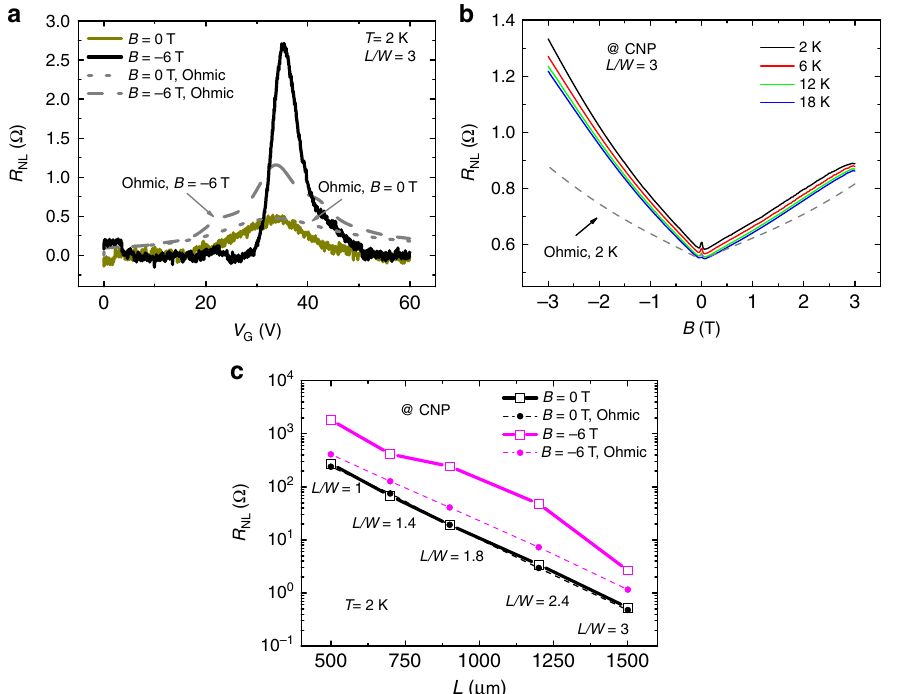
Fig. 2 Nonlocality in macroscale CVD graphene devices at low temperatures. a Nonlocal resistance as a function of back-gate voltage for a 500- μ m-wide and 1500- μ m-long Hall bar. b Nonlocal resistance as a function of the applied out-of-plane magnetic fi eld, at the CNP of graphene, for different temperatures. c Transmission line plot of the nonlocal resistance with channel length, at the CNP. In all fi gures, dashed lines represent the determined Ohmic contributions from four-probe measurements under equivalent